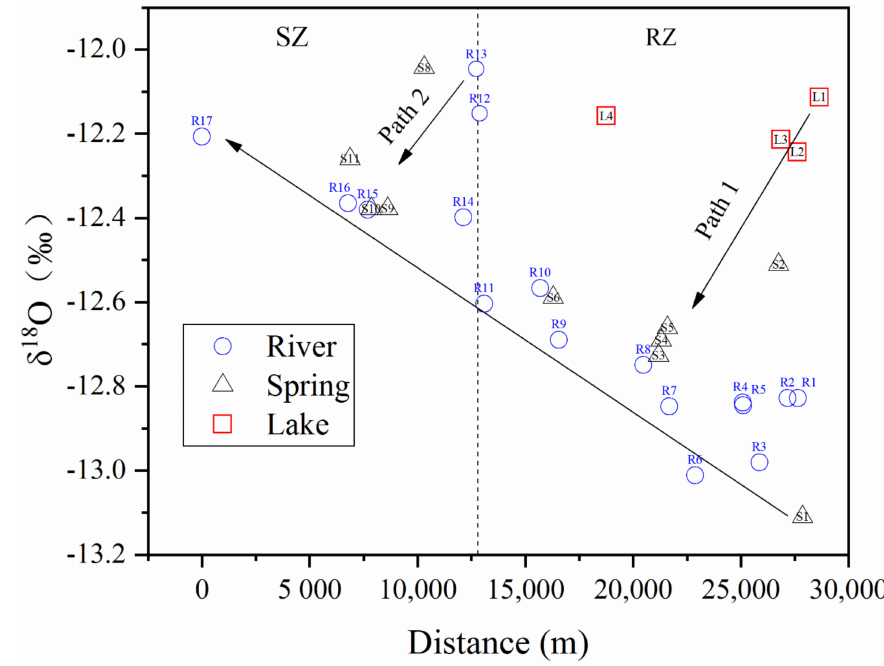
Figure 7. δ 18 O changes of water samples along three